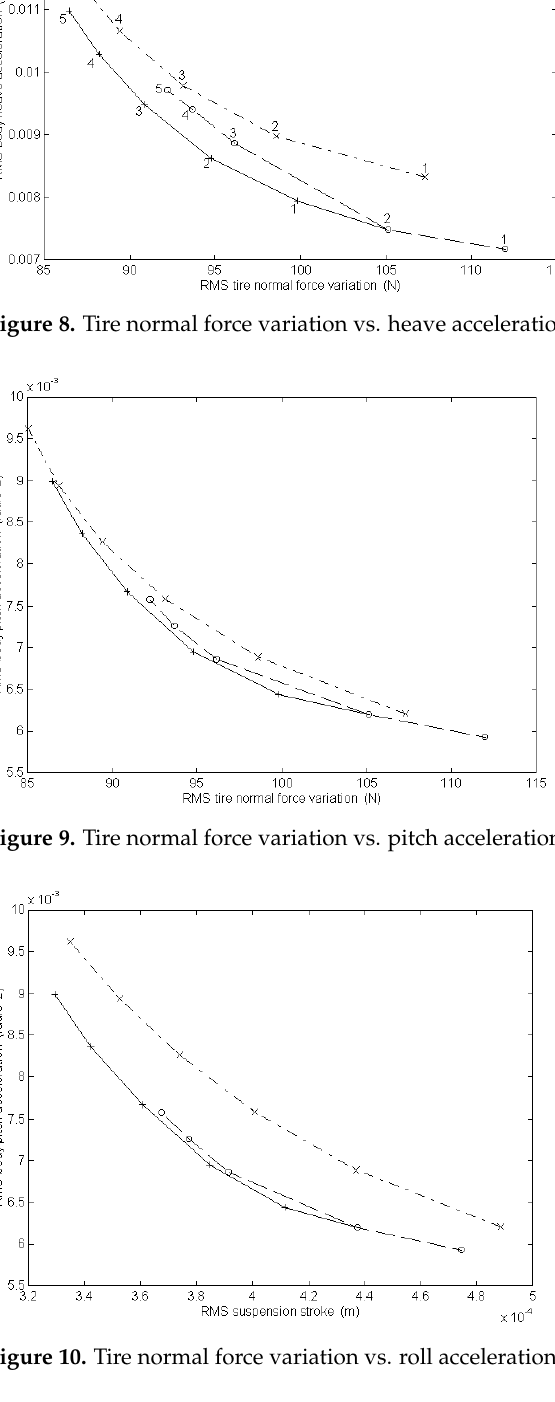
Figure 11. Frequency weighting function for roll and pitch acceleration. Figure 12. Frequency weighting function for heave acceleration. 5. Conclusions and Discussion A double sky-hook algorithm for application to in-wheel motored vehicle has been presented. It was proven that the double sky-hook algorithm could achieve a higher lev- el of compromise for road-holding and ride comfort compared to not only passive sus- pension, but also conventional sky-hook suspension. Even in the development vehicle with in-wheel motors, the double sky-hook damper for a semi-active suspension system could improve the vehicle dynamic stability and reduce suspension travel distance while maintaining a better ride comfort than the